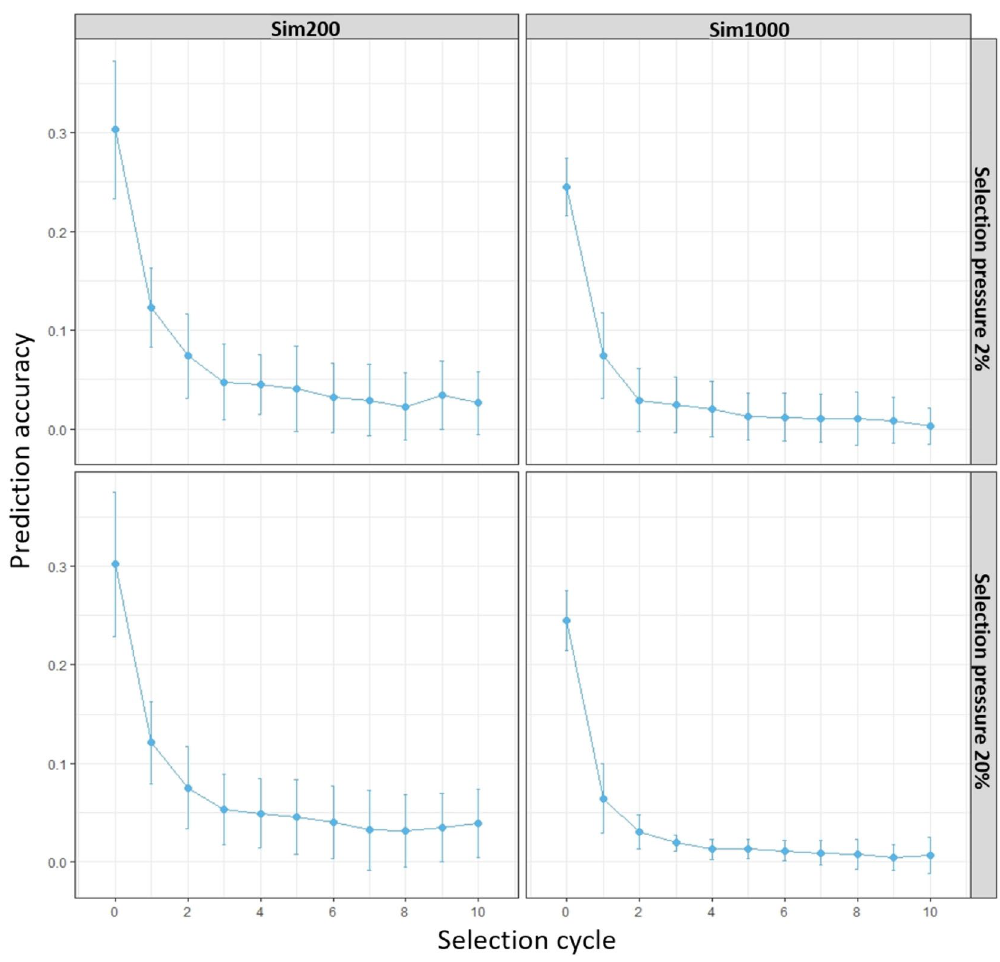
Figure 5. Average prediction accuracy estimated as the Pearson correlation co-efficient between true breeding value (TBV) and genomic estimated breeding value (GEBV) in the Sim200 and Sim1000 training populations. In each selection cycle prediction accuracy was based on 250